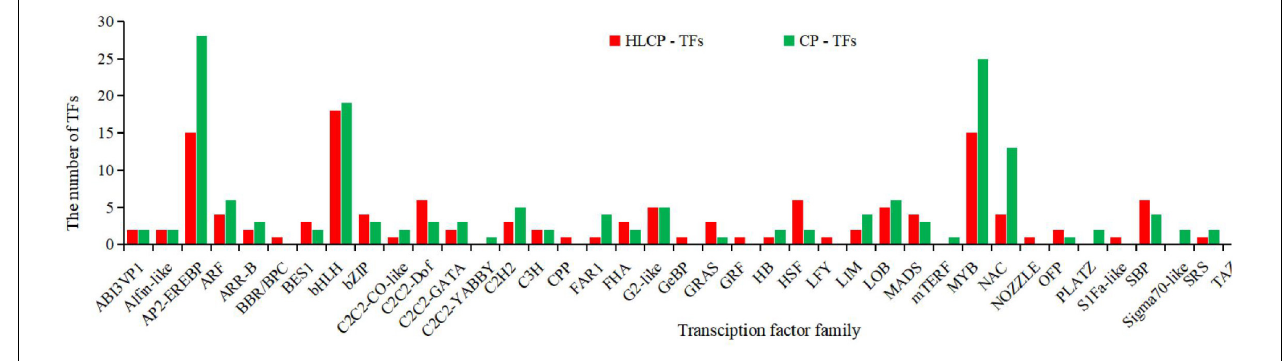
FIGURE 7 | Analysis of transcription factors of DEGs between the seed coats of hulled and hull-less C.